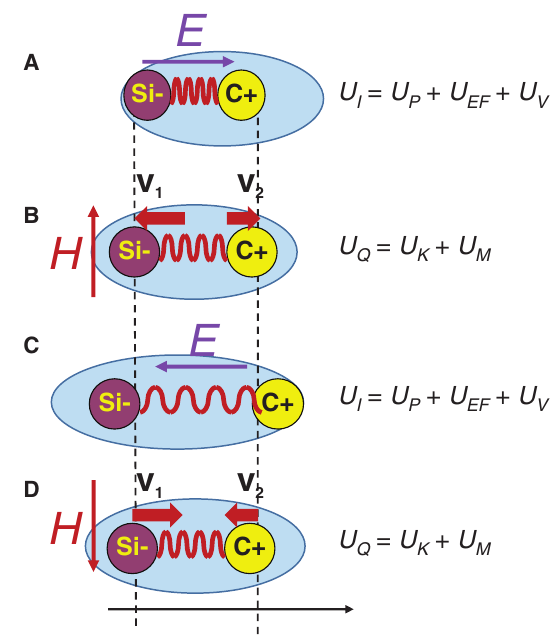
Figure 2: Energy breakdown in the polar dielectric material excited by the electromagnetic field for four different times within oscilla- tion period T: (A) t = 0, (B) t = T/4, (C) t = T/2, (D) t =